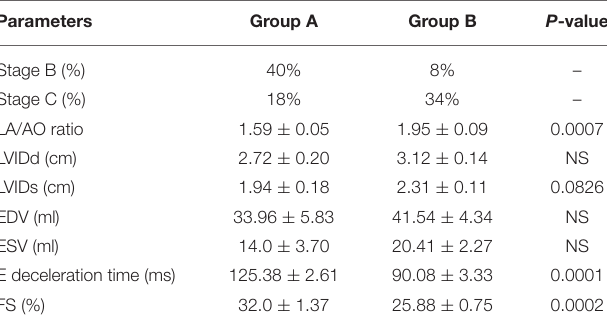
TABLE 3 | Echocardiography evaluation for two groups regarding left ventricular echocardiographic findings.